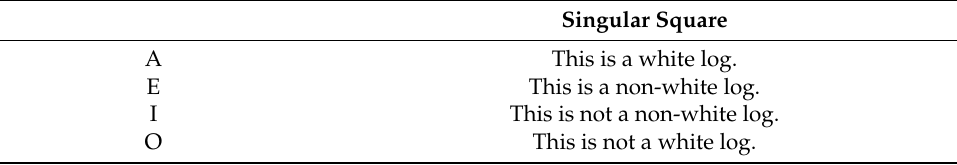
Table 3. Aristotle’s singular